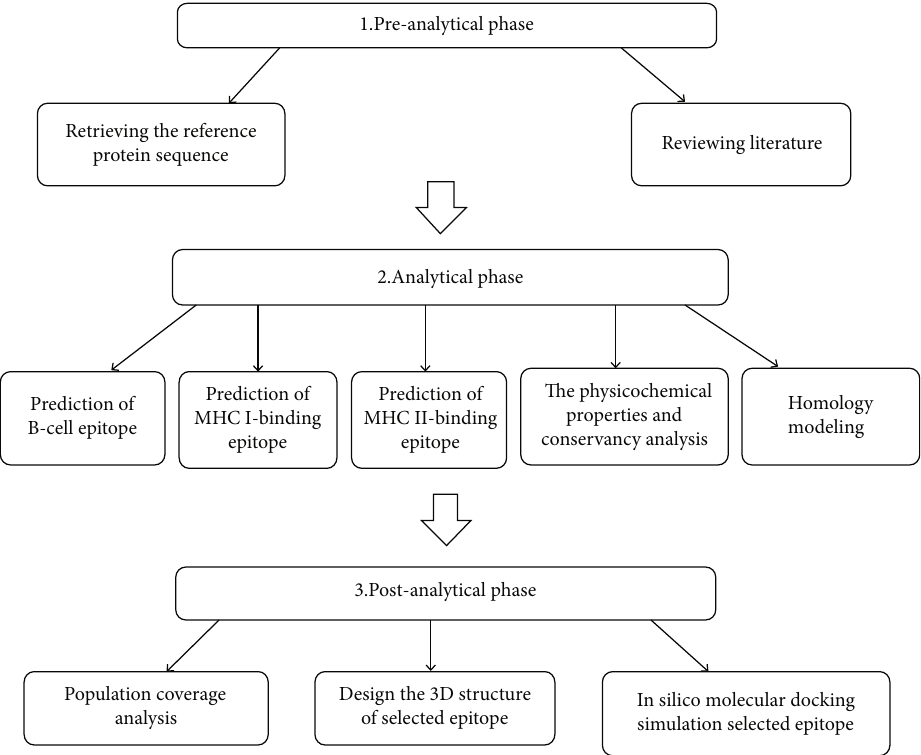
Figure 1: Schematic representation of the methodology